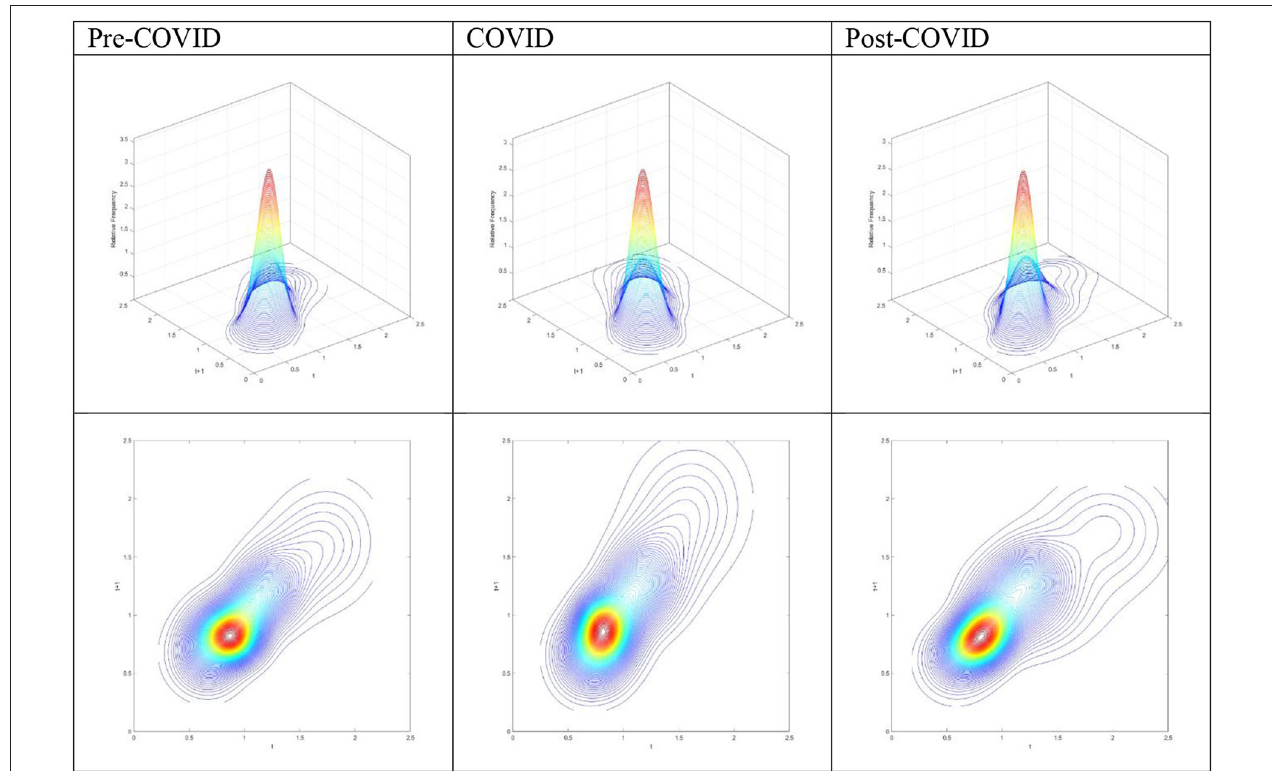
FIGURE 4 | Three-dimensional plot and Contour map of transition probability kernel for the RDIPC of all residents in cities with medium duration of Level I ERS with quarterly transitions during the Pre-COVID, COVID, and Post-COVID periods. Source: authors’ calculation.